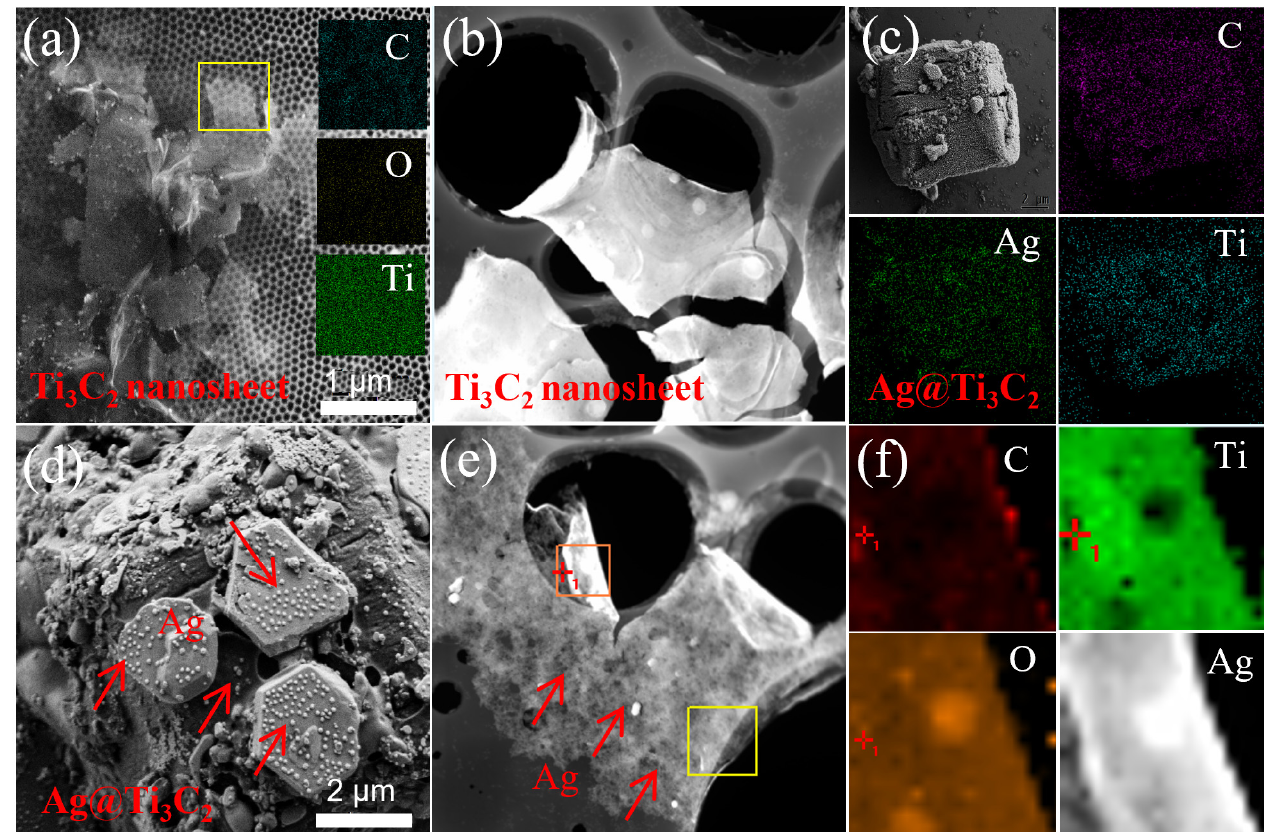
Figure 2. ( a , b ) TEM and EDS image of Ti 3 C 2 and ( c ) Ag@Ti 3 C 2 . ( d ) TEM image of conventional Ag@Ti 3 C 2 (e) The high-resolution TEM image ( f ) STEM-EDX mapping of Ag@Ti 3 C 2 .